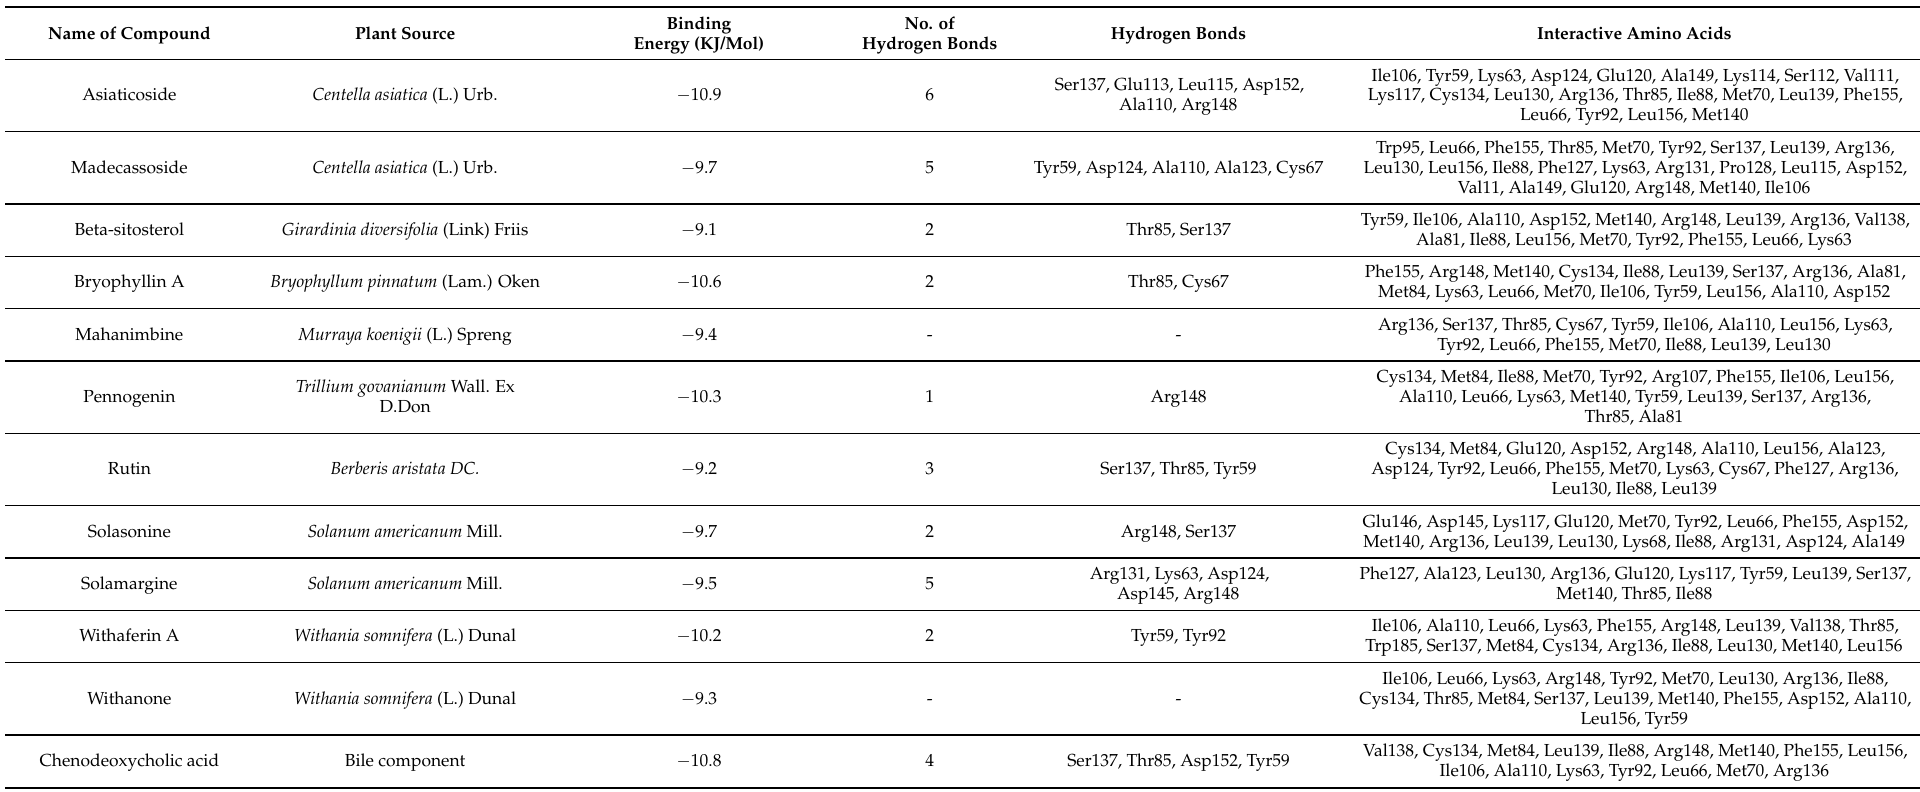
Table 2. Table describing the active phytocompounds, plant source, binding energy, and interactive amino